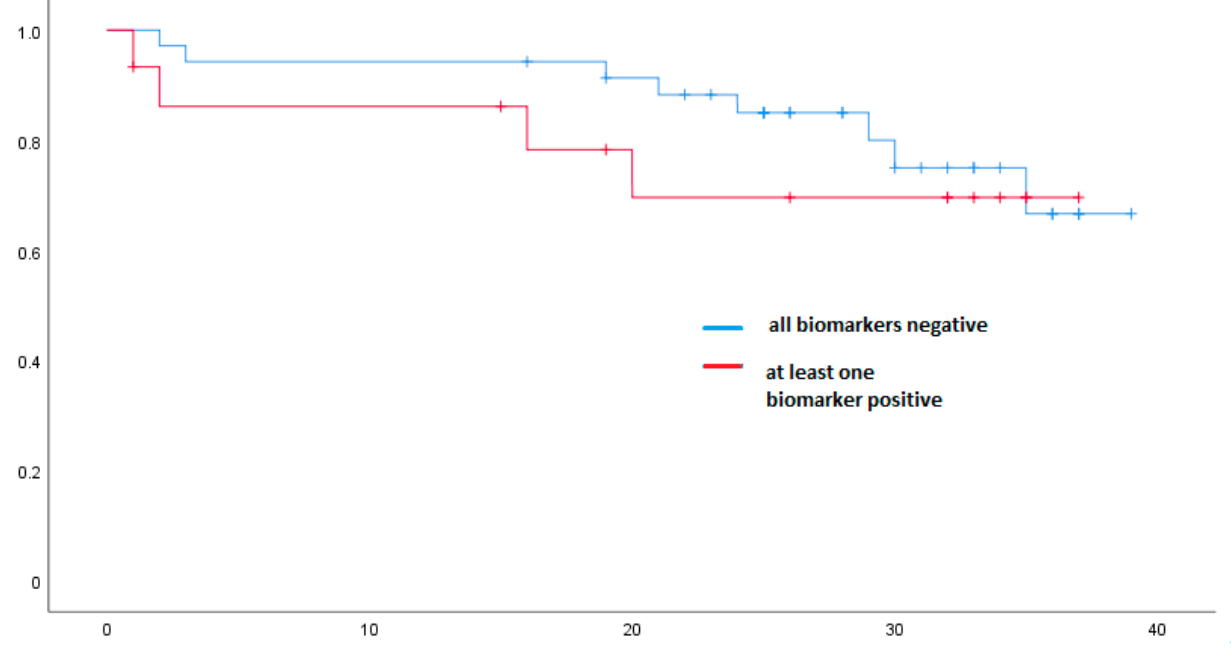
Figure 1. Kaplan–Meier plot depicting survival (in months) according to biomarker status at baseline.